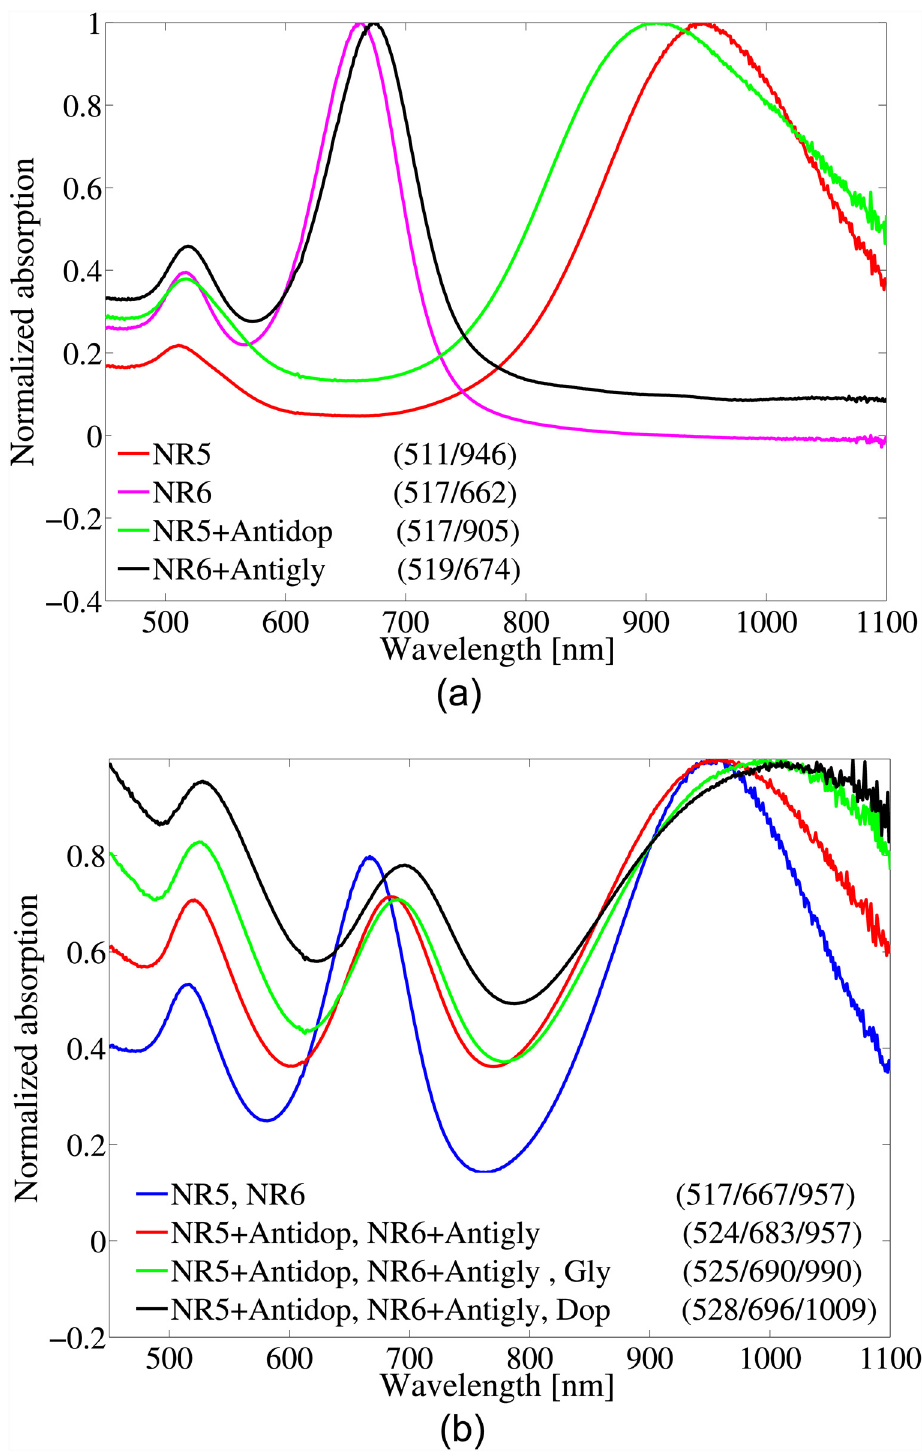
Fig 6. a) Absorption spectra of NR5 and NR6 before and after functionalizing with the receptors, and b) using the mixture of the functionalized GNPs to detect both Dop and Gab. The numbers in parenthesizes report the peak wavelengths of each curve in units of nm